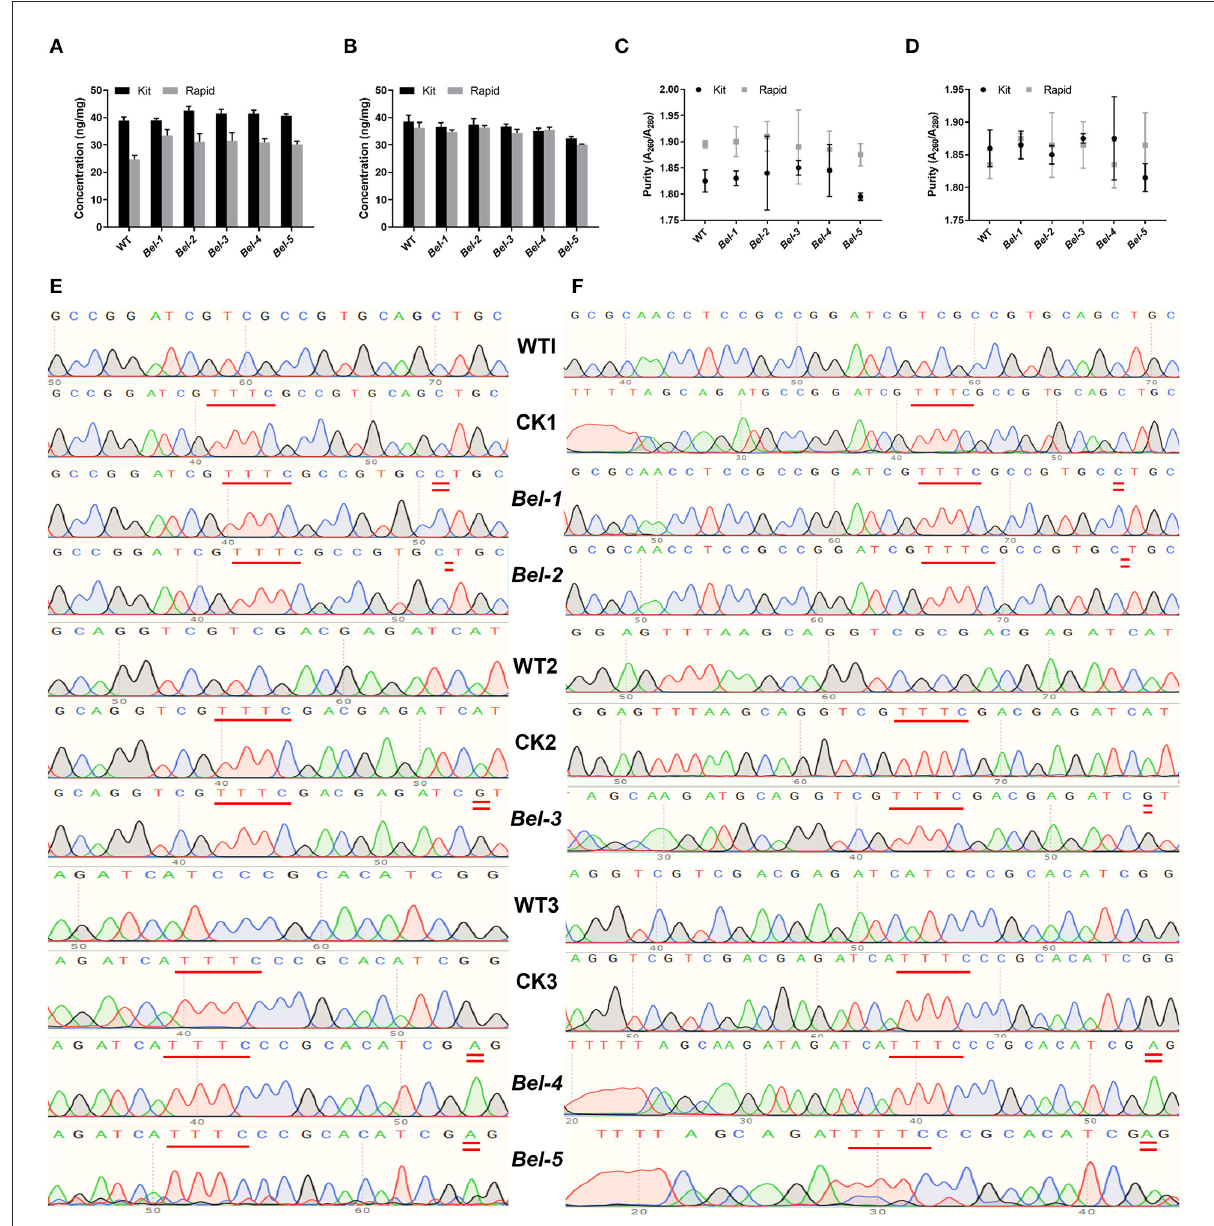
FIGURE2 Concentration and purity of sample DNA extracted by two methods, and sequencing results for the polymerase chain reaction (PCR) and RPA products. (A) Seed DNA concentration. (B) Leaf DNA concentration. (C) Seed DNA purity. (D) Leaf DNA purity ( n = 3, error bars show the mean ± SD). (E) PCR products of the wild-type (WT), control check (CK) (compared with the WT, a PAM was inserted in CK1, CK2, CK3), and five mutants. CK1, CK2, and CK3 represent three different editing sites. (F) RPA products of the WT, CK, and five